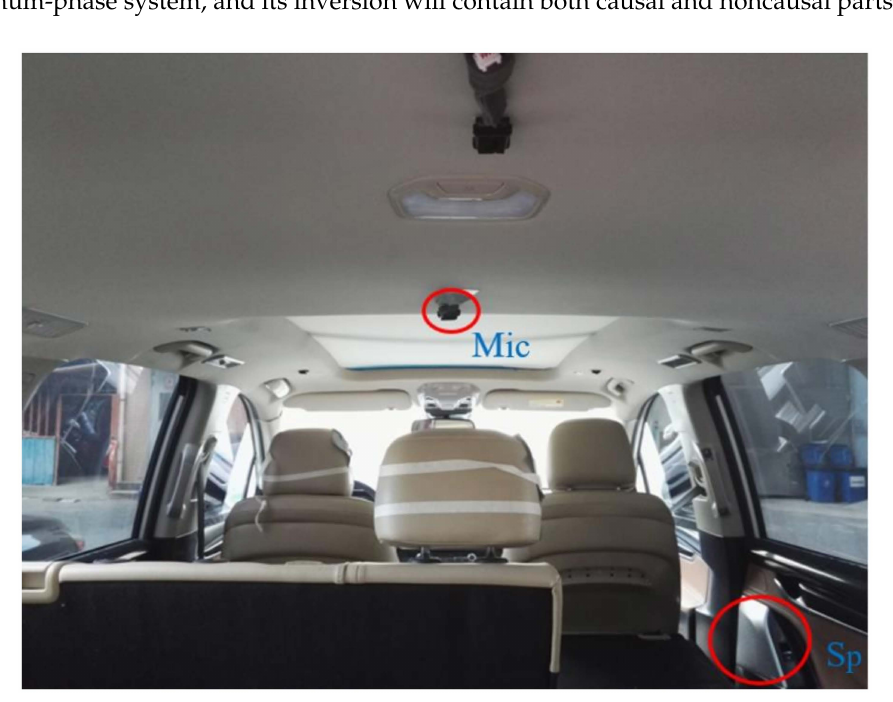
Figure 2. The positions of the loudspeaker and error